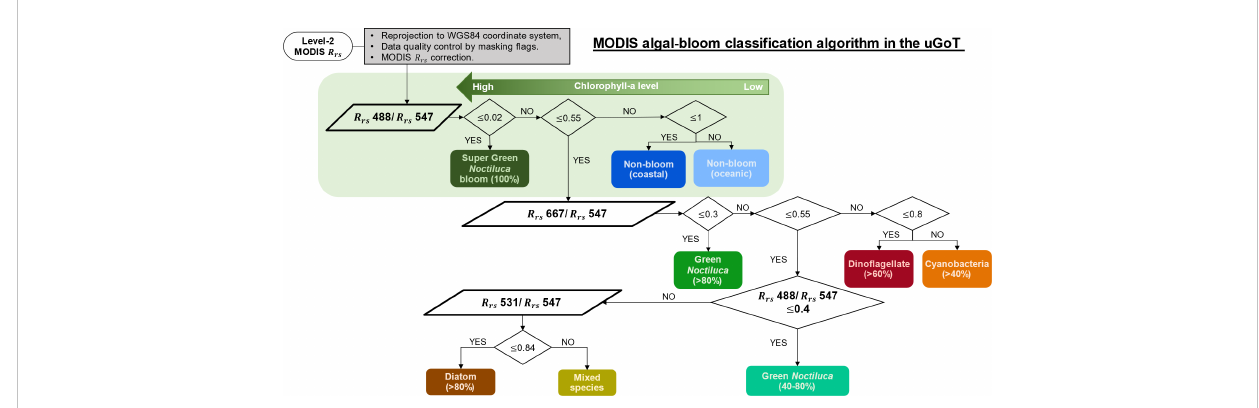
FIGURE 5 Flow diagram of MODIS data processing for discriminating algal blooms in the